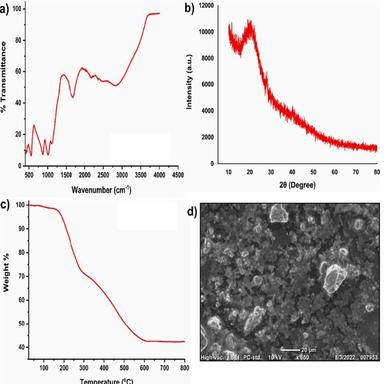
Characterization of SL: a) FTIR; b) XRD; c) TGA; and d) SEM images (scale bar 20 μm).